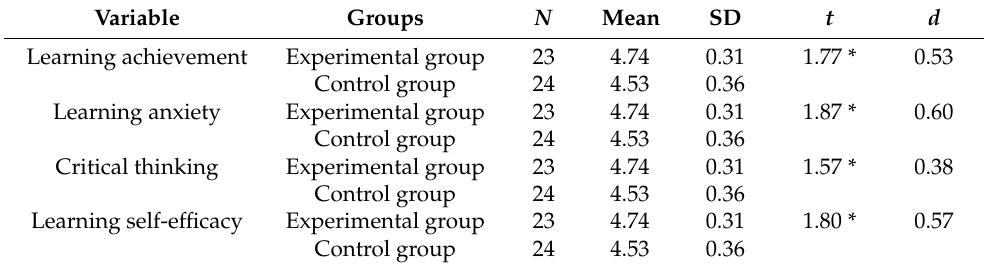
t -test results for learning achievement, learning anxiety, critical thinking, and learning